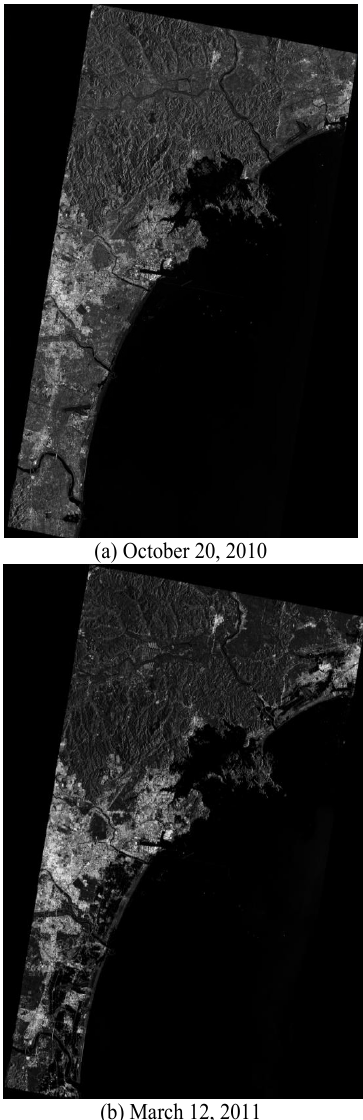
Figure 2. Pre- and post-event TSX images acquired respectively on October 20, 2010 (a) and March 12, 2011 (b). The two TSX images have been accurately co-registered and radiometrically calibrated.